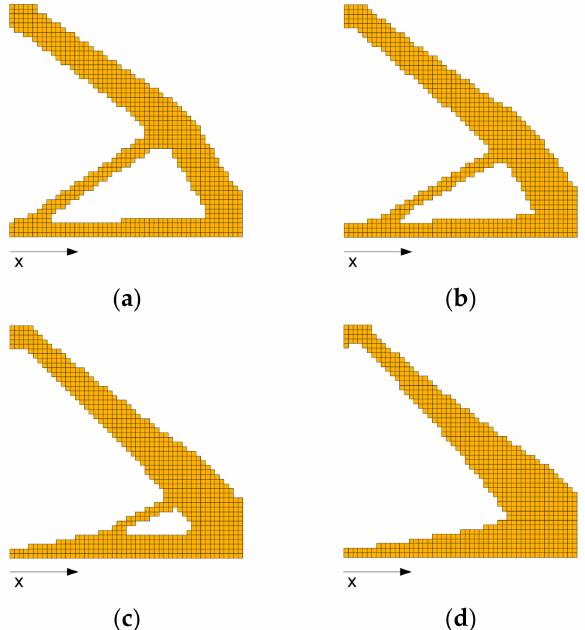
Figure 5. Final topologies obtained for square structure using the FGM-SIMP material interpolation scheme, x -direction of material gradation: ( a ) α = − 0.02, minimal compliance: 4.386 Nm; ( b ) α = − 0.04, minimal compliance: 7.919 Nm; ( c ) α = − 0.06, minimal compliance: 15.427 Nm; ( d ) α = − 0.08, minimal compliance: 31.656